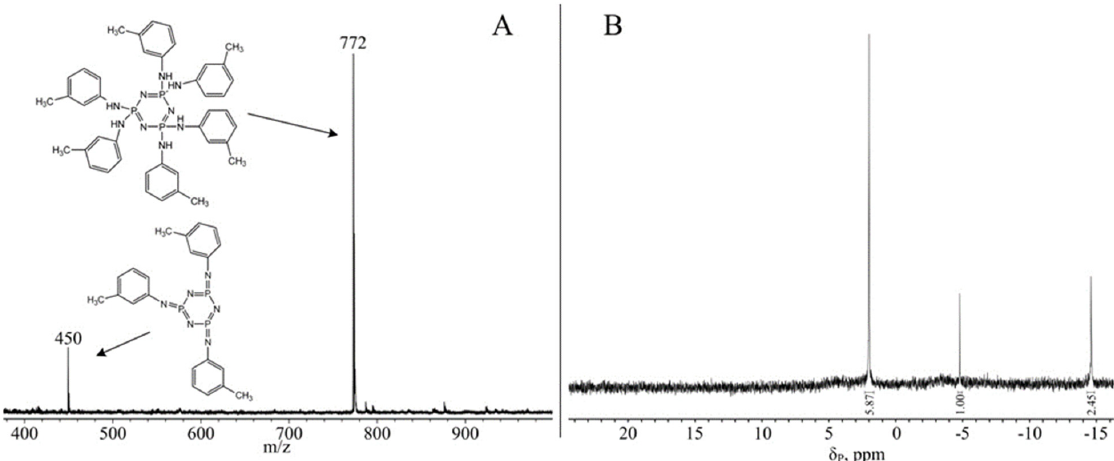
solved for analysis, it was noted that the pyrolysis products were completely soluble, in- dicating a lack of cross-linked polymer products. By means of MALDI-TOF, it was deter- mined that the pyrolysis at selected conditions is partially leaking as there is a signal of the initial AAP in the spectrum (Figure 6A, shown by the example m-AAP). However, there is also a peak in the spectrum corresponding to the mass of the product pyrolysis Figure 5. It is noteworthy that the signals of the intermediate pyrolysis products, i.e., one or represented in Figure 5. It is noteworthy that the signals of the intermediate pyrolysis two separated aniline molecules, are absent from the spectrum. products, i.e., one or two separated aniline molecules, are absent from the spectrum.